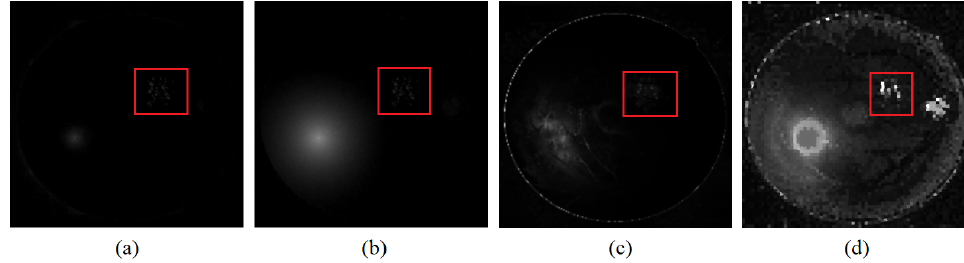
Figure 10. Detected change region for the image pair with small lesions in Figure 4. ( a ) P-RPCA;